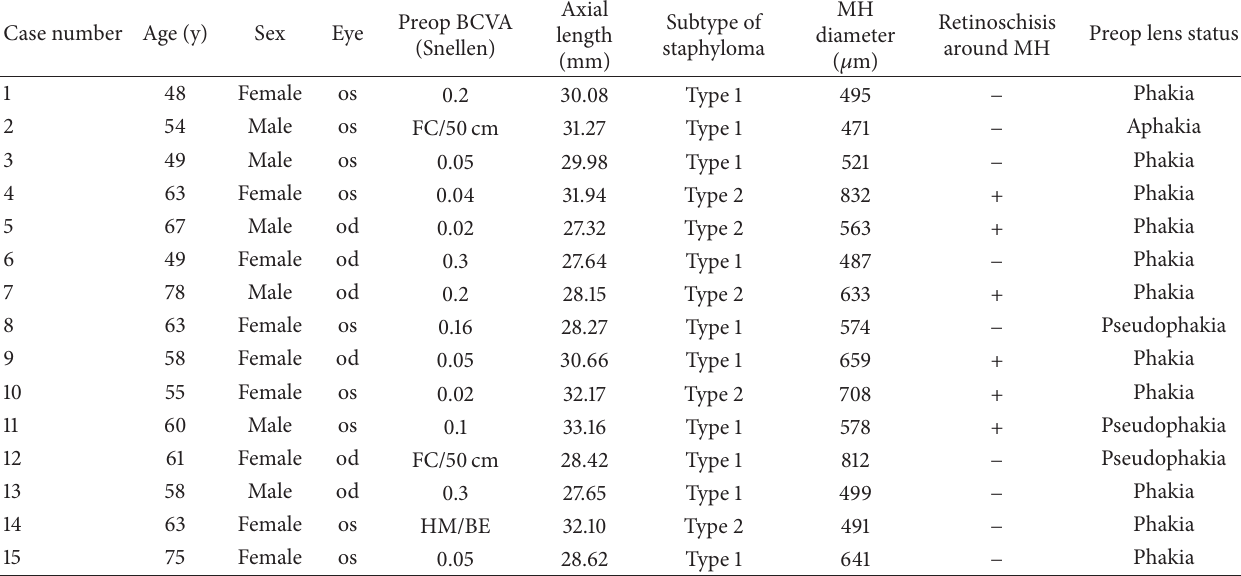
Table 1: Baseline clinical characteristics of highly myopic patients with large macular holes ( 𝑛 = 15 ).